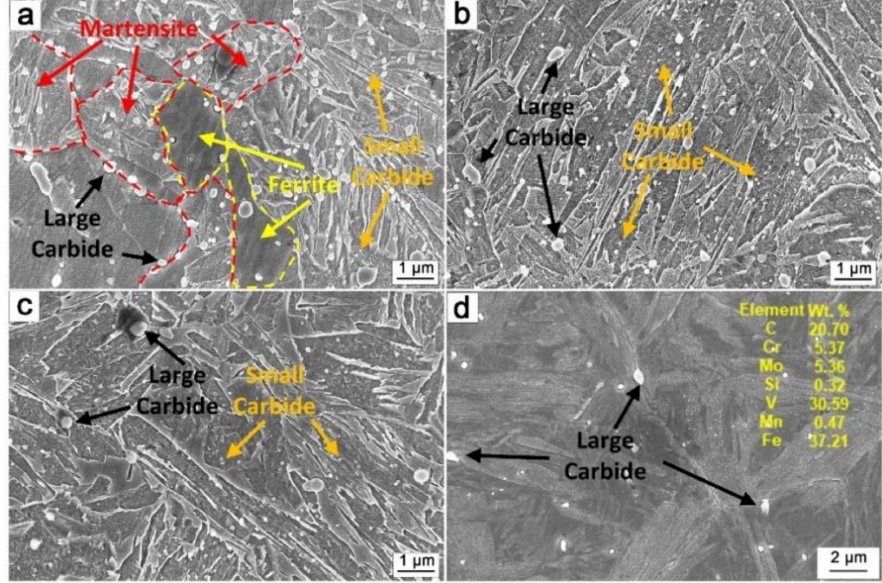
Figure 3. SEM images of stage I: ( a ) 850-I; ( b ) 900-I; ( c ) 950-I; ( d ) 0-I. In the early stage of intercritical annealing, the reverse austenite formation process included nucleation and growth at the interface. Martensite plates were decomposed, resulting in the formation of ferrite. Carbide precipitation behaviors are different in ferrite and austenite due to the difference in the chemical composition induced by the element partitioning during intercritical annealing. C and Mn tended to diffuse into the reversed austenite, while Cr and V tended to be in the ferrite [24]. On the one hand, the M 7 C 3 nucle- ation driving force is insufficient with low C content, and a large number of precipitates will not be precipitated in the ferrite (Figure 3a). On the other hand, the increase in the number of γ / α interface promotes the formation of interfacial precipitates which enter the interior of the γ phase from the interface with its growth. When the annealing temperature reaches 850 ◦ C, a two-phase region, a stable γ / α interface is found. The interface will become a diffusion channel for solute atoms promoting the growth of precipitates formed on the interface. Annealing at 900 and 950 ◦ C produces an austenite single-phase region, while the γ / α interface only exists in the early stage of phase transformation. The precipitated VC at the interface does not undergo significant coarsening due to the disappearance of the interface and the local diffusion of V atoms. In addition, abundant C atoms in austenite are conducive to VC nucleation during intercritical annealing. This further reduces the V concentration and suppresses the coarsening behavior. The large-sized VC, which was the undissolved carbides during the austenitizing, was observed in martensite (Figure